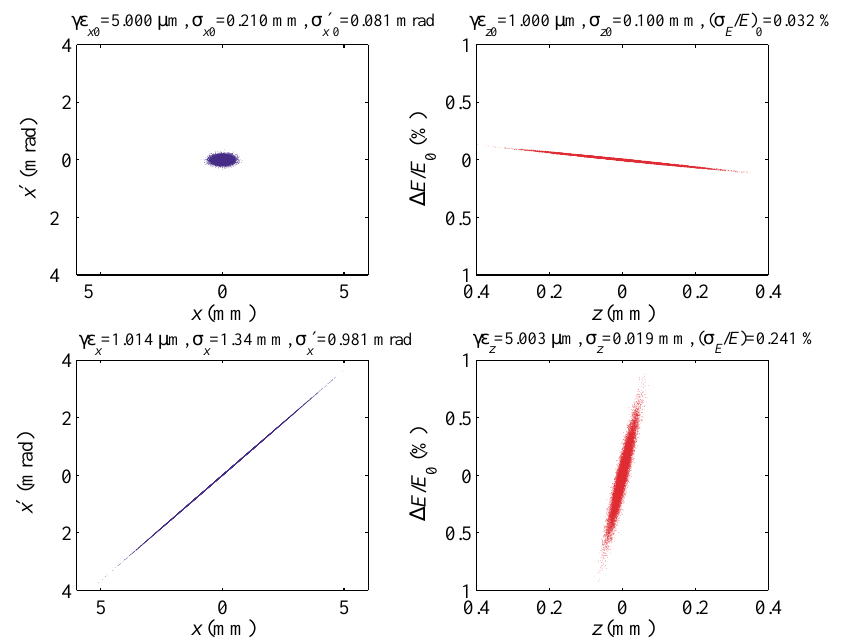
FIG. 4. (Color) Initial (top) and final (bottom) phase space tracking plots with thick-lens cavity and a z set according to (44). The emittances are still completely exchanged.